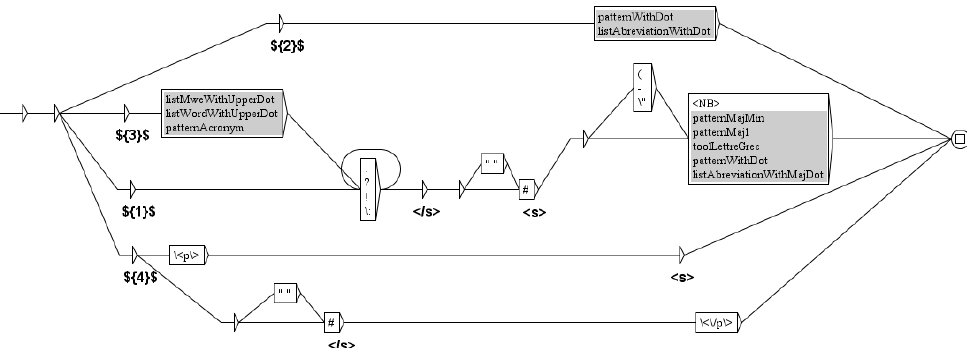
Figure 6. This graph splits the text in sentences and adds the TEI tags for sentences: < s > and < / s >